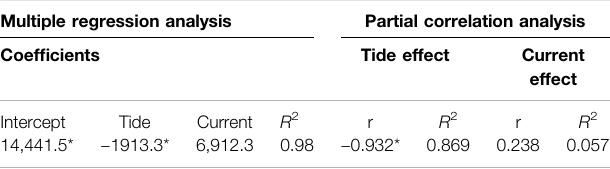
TABLE 2 | Multiple regression and partial correlation analysis results from the Arroyo Quemado tidal